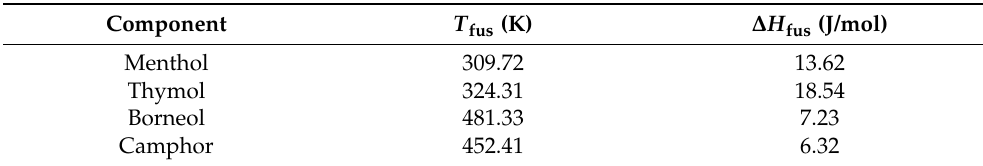
Table 4. Experimental data of the melting temperature ( T fus ), enthalpy of fusion ( ∆ H fus ), of the pure terpenes.